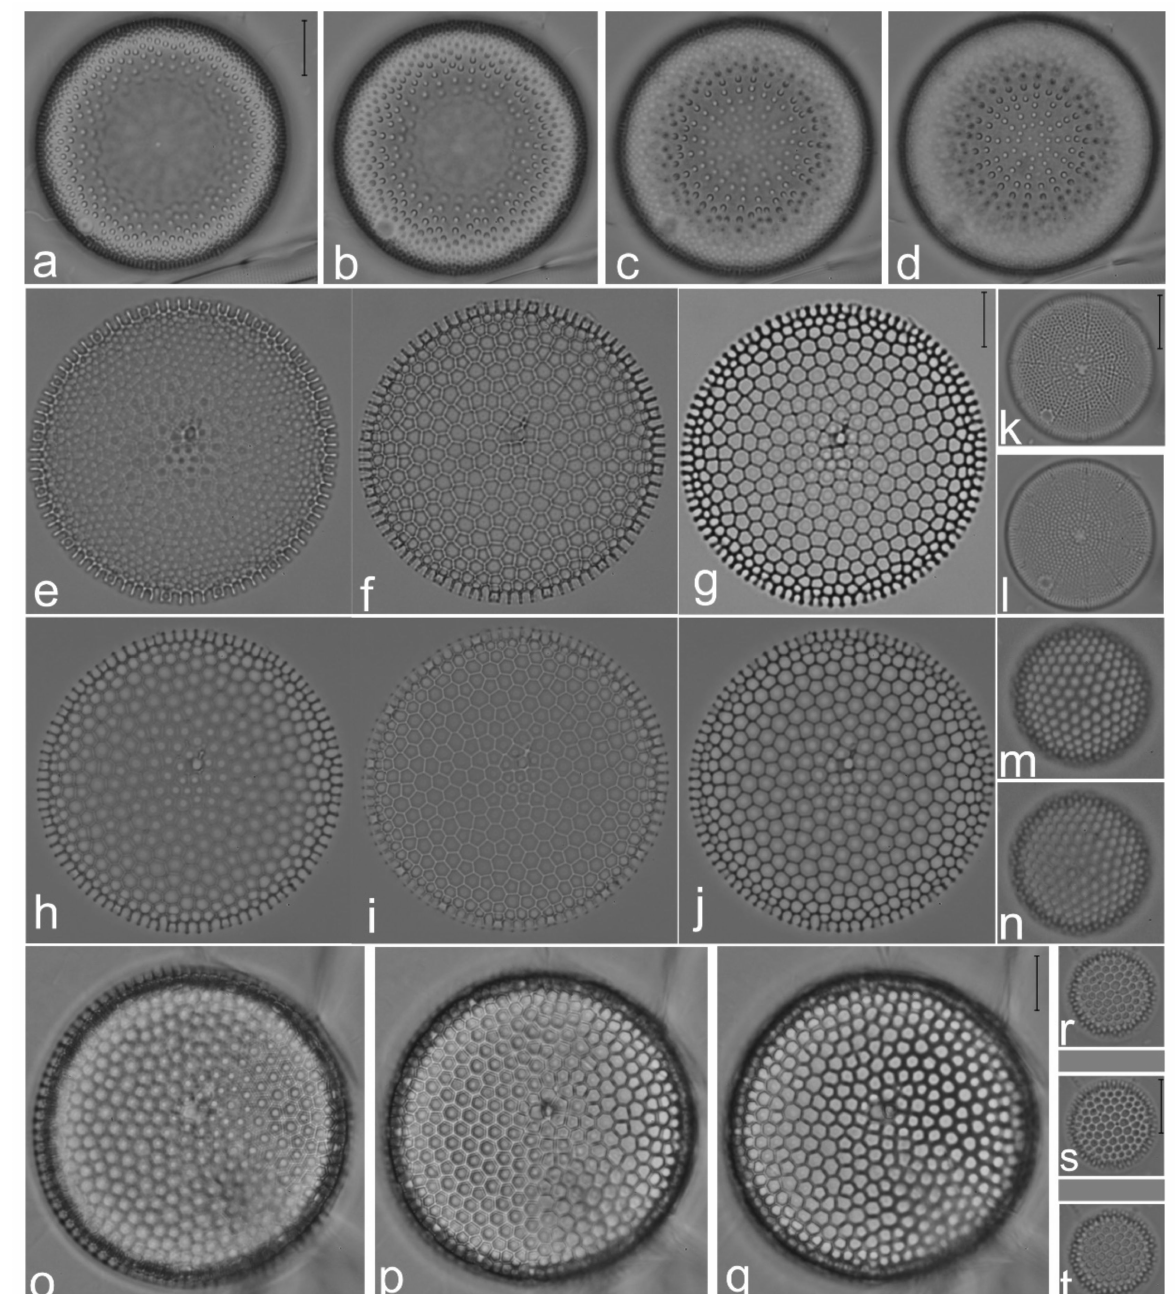
Figure 3. ( a – d ) Actinocyclus crassus valves in different focal views; ( e – j ) Coscinodiscus radiatus in different focal planes; ( k , l ) Actinocyclus octonarius var. sparsus ; ( m – q ) Azpeitia nodulifera ; ( r – t ) Shionodiscus oestrupii in different focal planes and showing a range in size. Scale bar = 10 µ